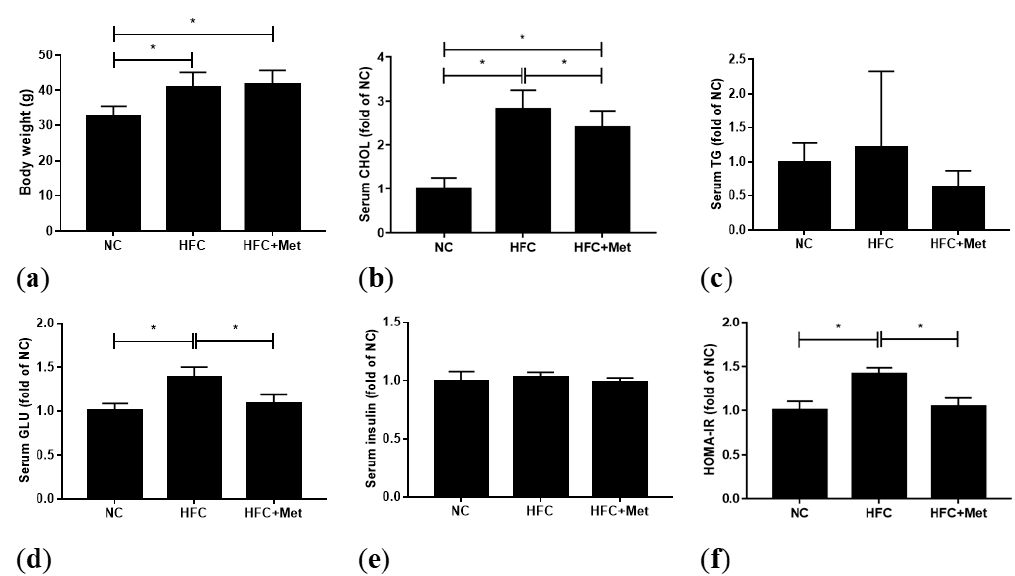
Figure 1. Effects of the high-fat and high-cholesterol diet and metformin supplementation on ( a ) body weight, ( b ) serum total cholesterol (CHOL), ( c ) serum triglycerides (TG), ( d ) serum glucose (GLU), ( e ) serum insulin level and ( f ) homeostasis model assessment of insulin resistance (HOMA-IR) in the male mice: Data are expressed as means ± SD. ( Figure 1a: n = 10–15; 1b–f: n = 4–8 per group). * p < 0.05